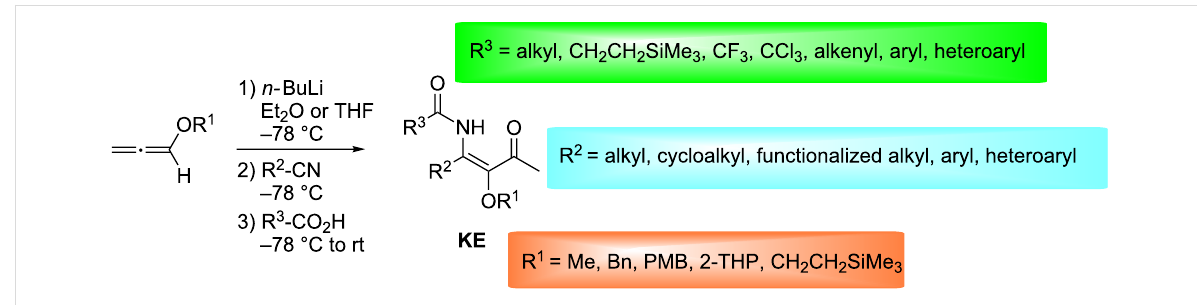
Scheme 4: Synthesis of β -ketoenamides KE by the LANCA three-component reaction of alkoxyallenes, nitriles and carboxylic